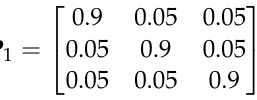
Figure 9. Comparison of algorithm with reference [13]. ( a ) RMSE of position; ( b ) Change of trace value k K of position gain matrix of Jerk model.